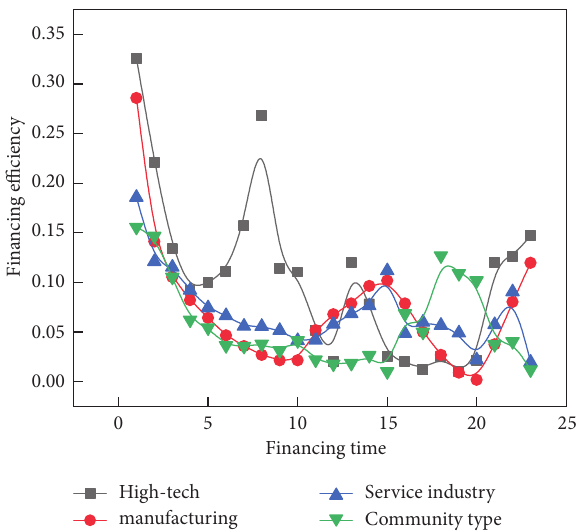
Figure 8: Time curve of efficiency in financing of each enterprise. Table 1: Changes in different enterprises under multiple